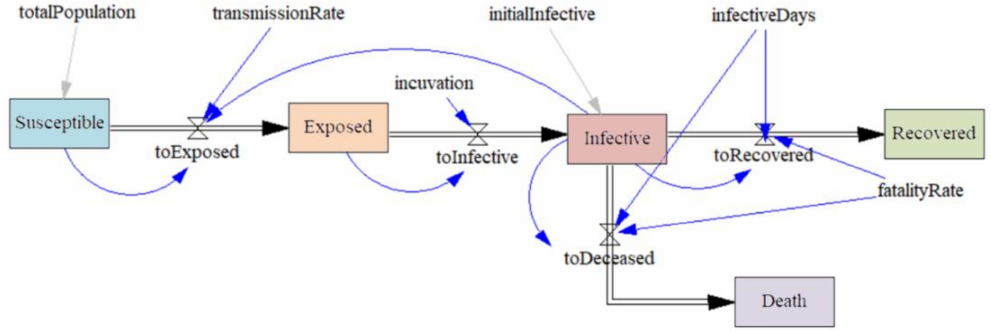
Figure 2. SD models implemented in Vensim